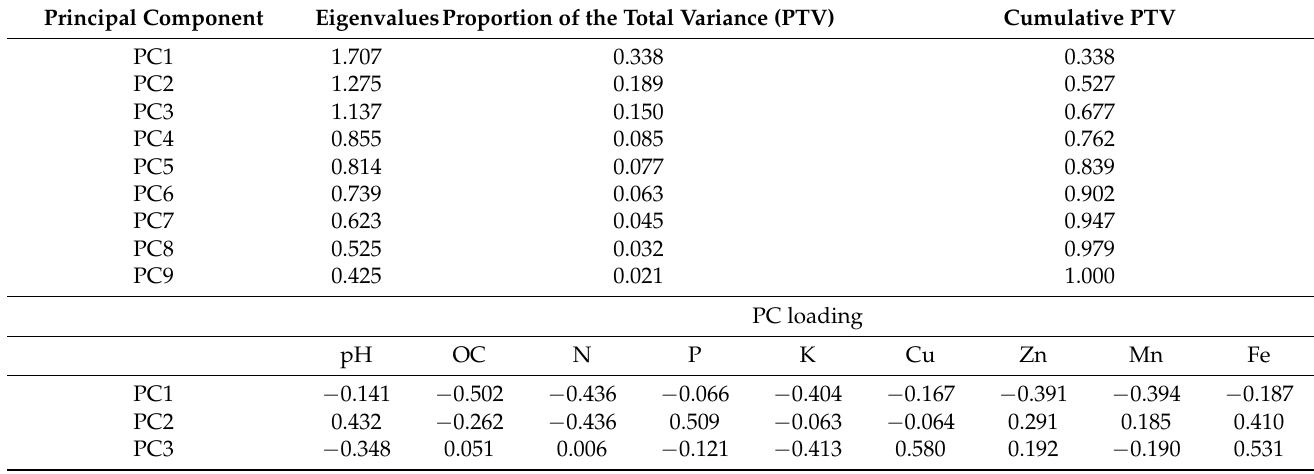
Table 6. Soil properties and loading coefficients: global principal component